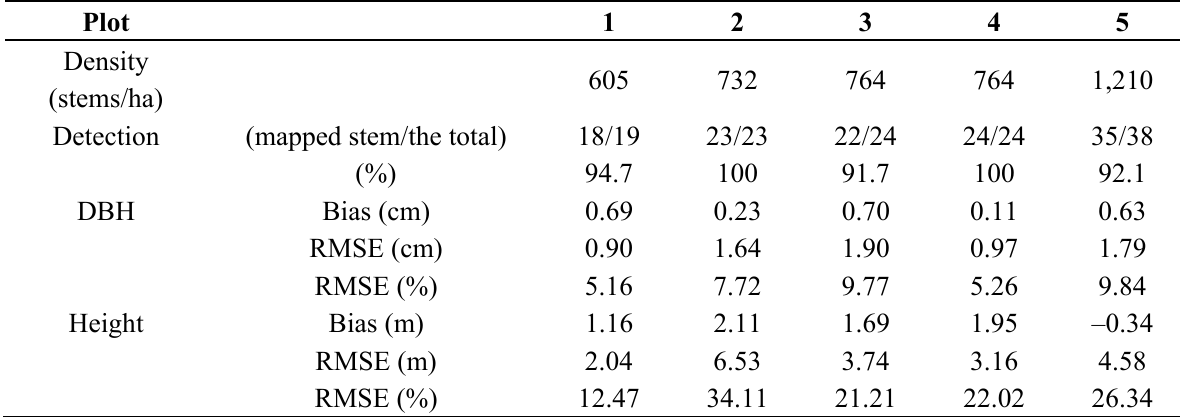
Table 3. The results of stem mapping using the MSS method.